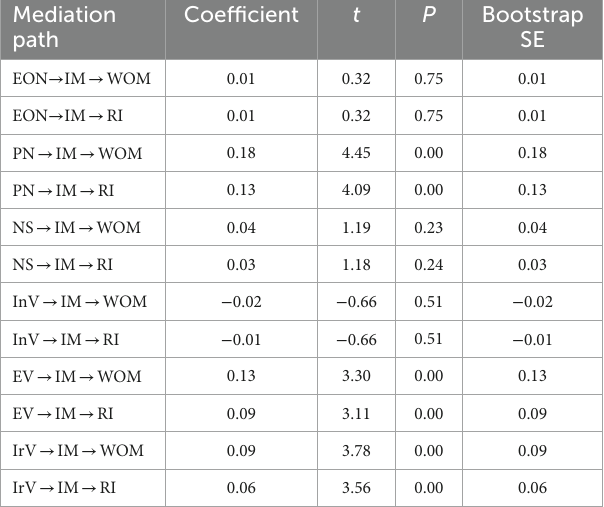
TABLE 6 Mediation analysis results of immersive